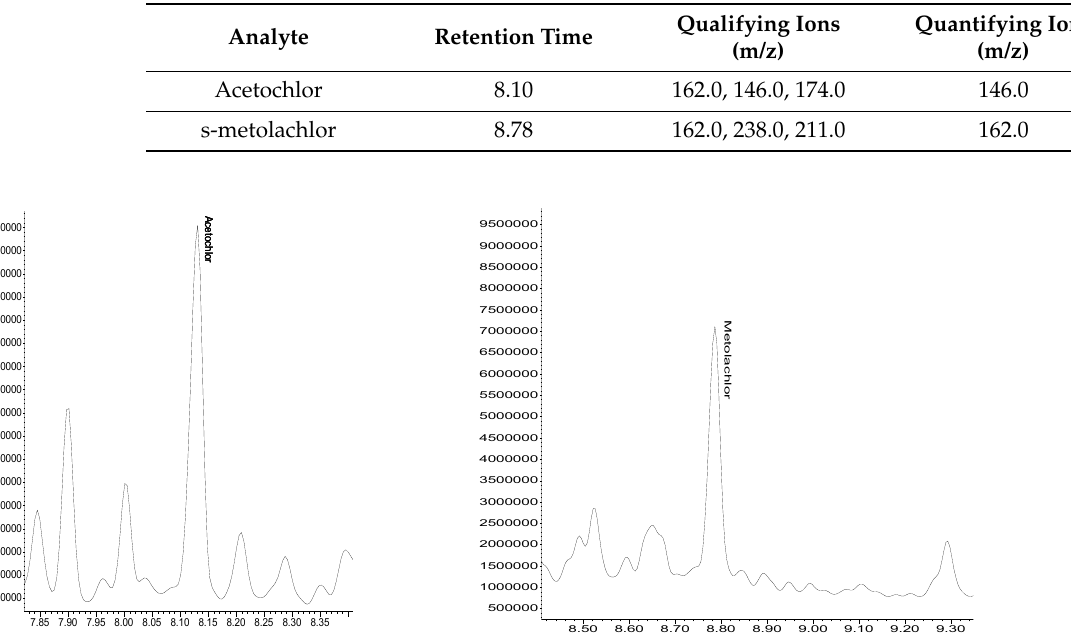
Table 1. Gas chromatography–tandem mass spectrometry (GC-MS) parameters of acetochlor and s-metolachlor.